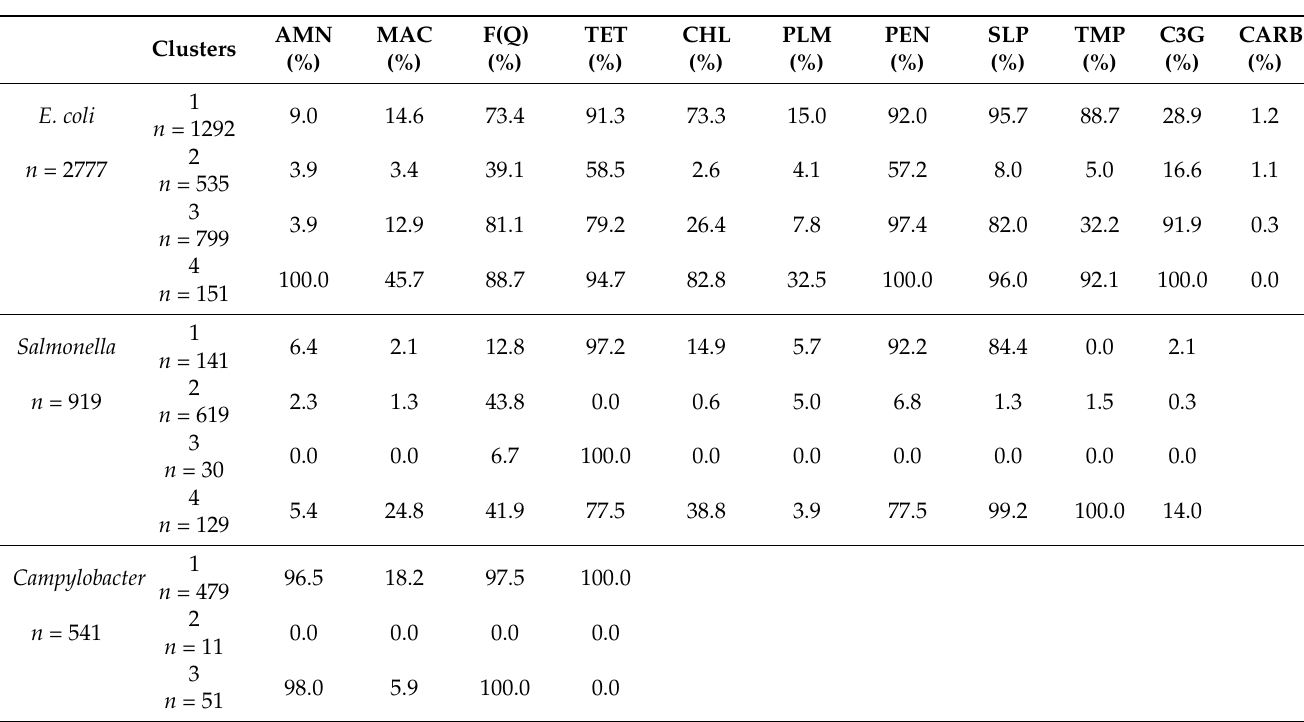
Table 2. Clusters using antimicrobial susceptibility testing results from Escherichia coli , Salmonella, and Campylobacter isolates observed between 2014–2019 in food-producing animals and derived meat samples. Clusters were created by assessing similarity between isolates and number of mismatches in AST results. Resistance percentages by antimicrobial class and bacterial genus are presented for each